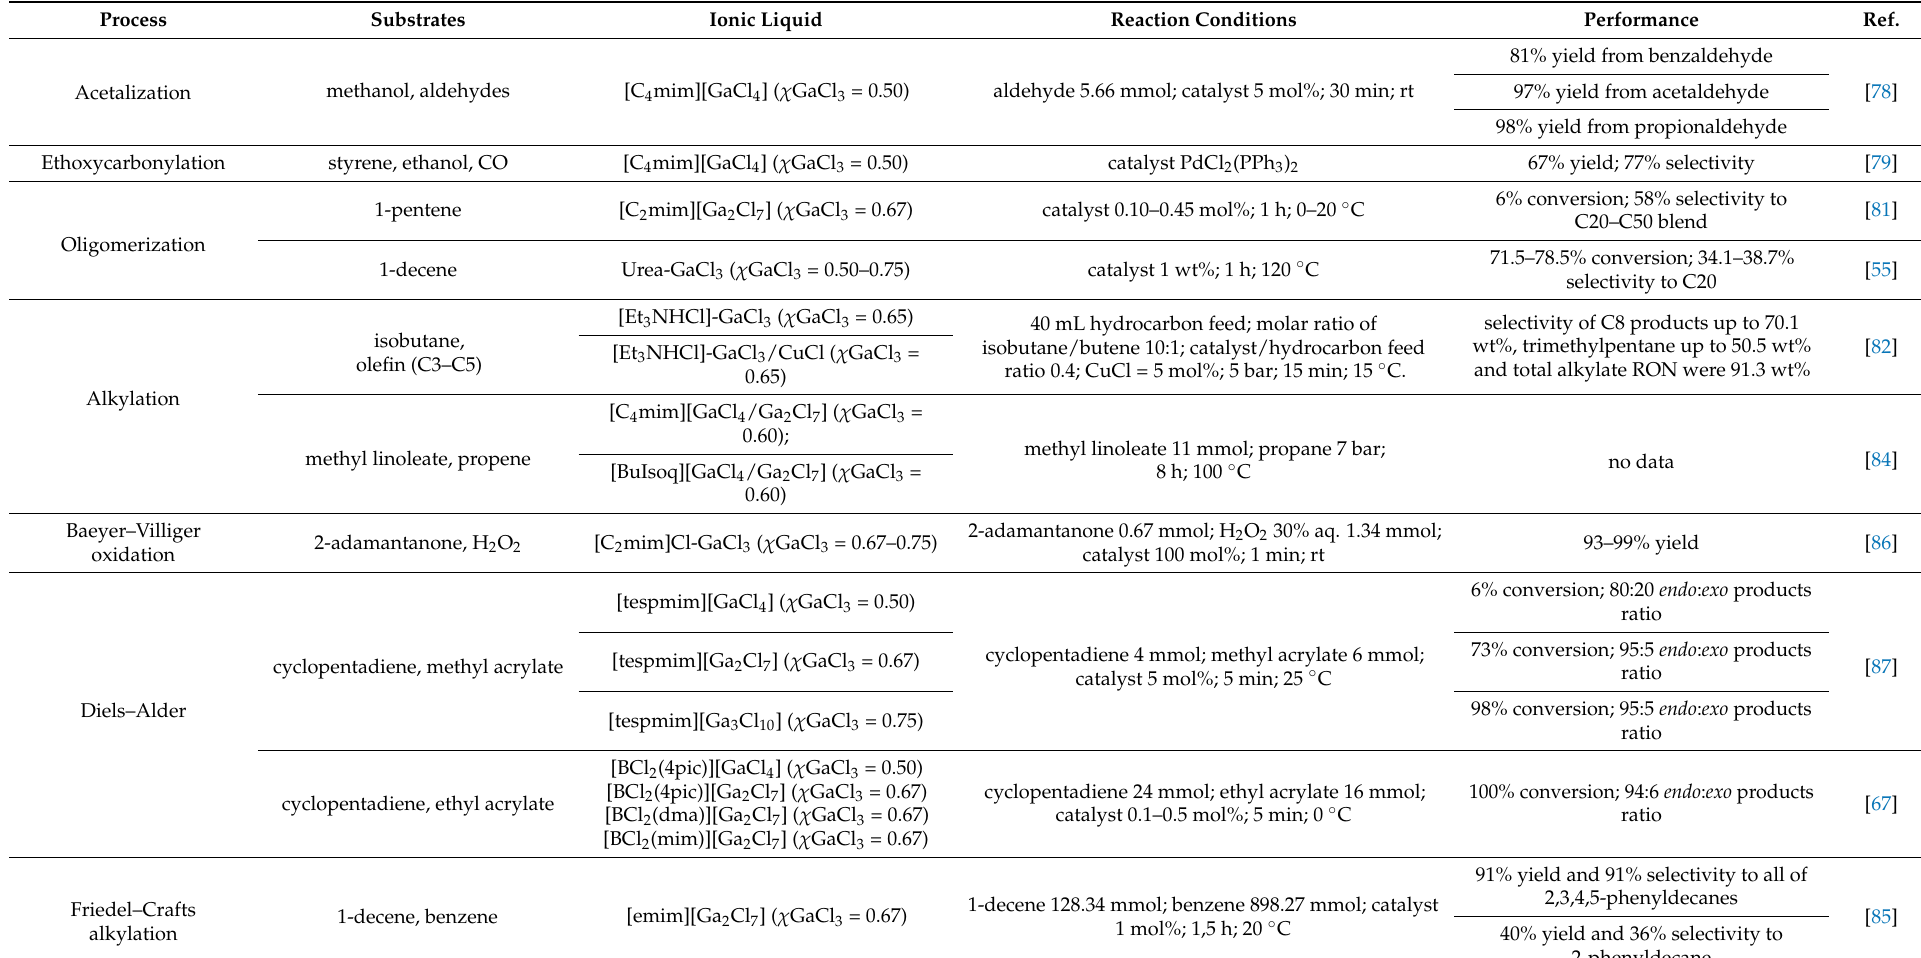
Table 3. Summary of reactions catalysed by gallium(III)-based